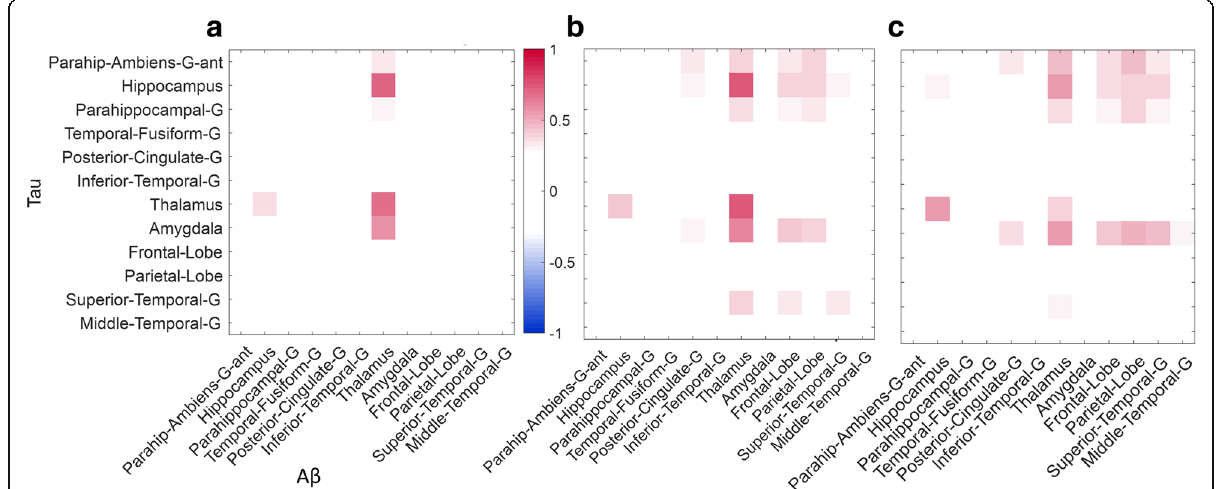
Fig. 5 Signed coefficient of determination ( R 2 ) of regional BP ND values derived using SRTM ( a ), reference Logan graphical analysis ( b ) and SUVR ( c ) methods for 12 regions with high potential for A β or tau uptake (The values between − 0.3 and 0.3 are masked for easier interpretation)